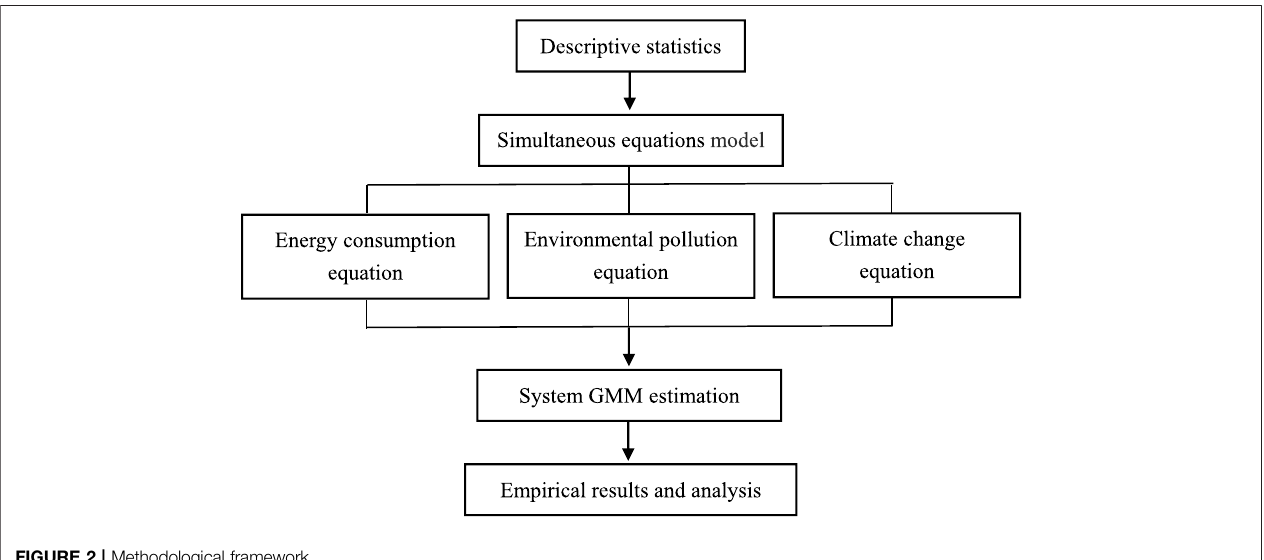
FIGURE 2 | Methodological